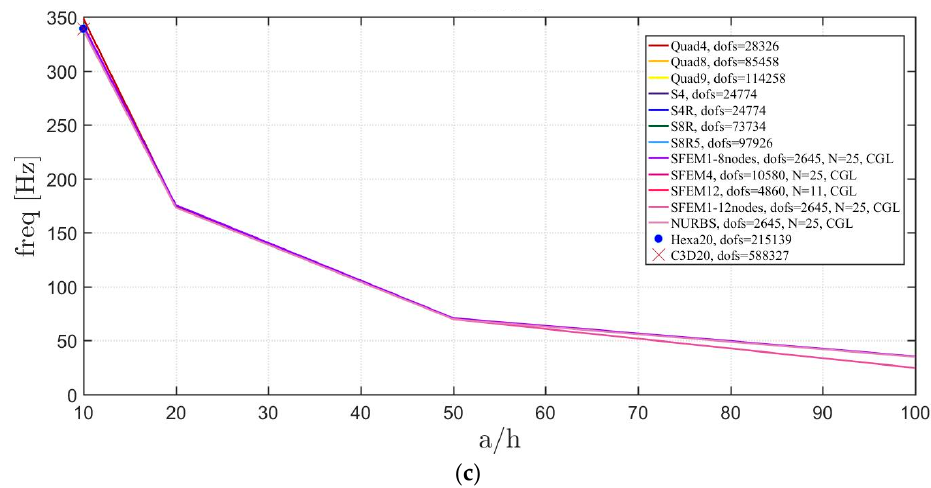
Figure 11. Thickness effect on the first three natural frequencies of an isotropic elliptic plate with a / b = 2: ( a ) First frequency; ( b ) Second frequency; ( c ) Third frequency.